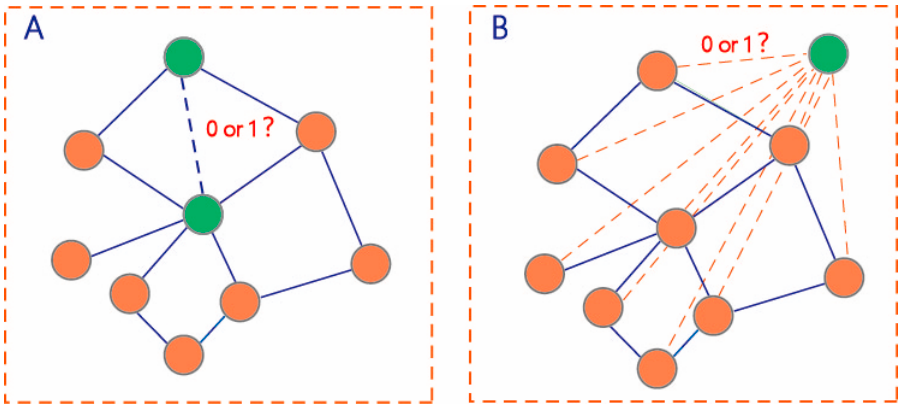
Figure 2. Two scenarios of DDI prediction. ( A ) DDI prediction among drugs in the DDI network ( B ) DDI prediction between the drugs within the DDI network and new drugs outside the network.